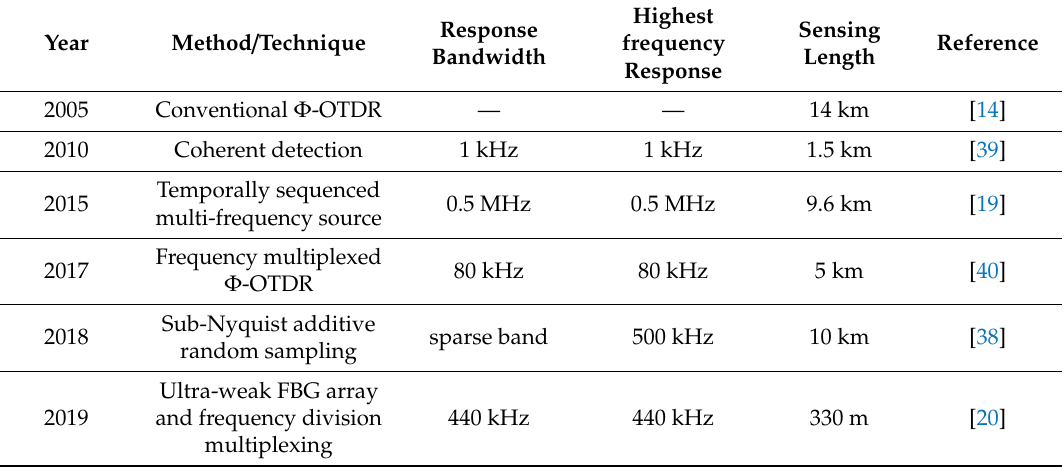
Table 2. Typical response bandwidth / frequency with di ff erent